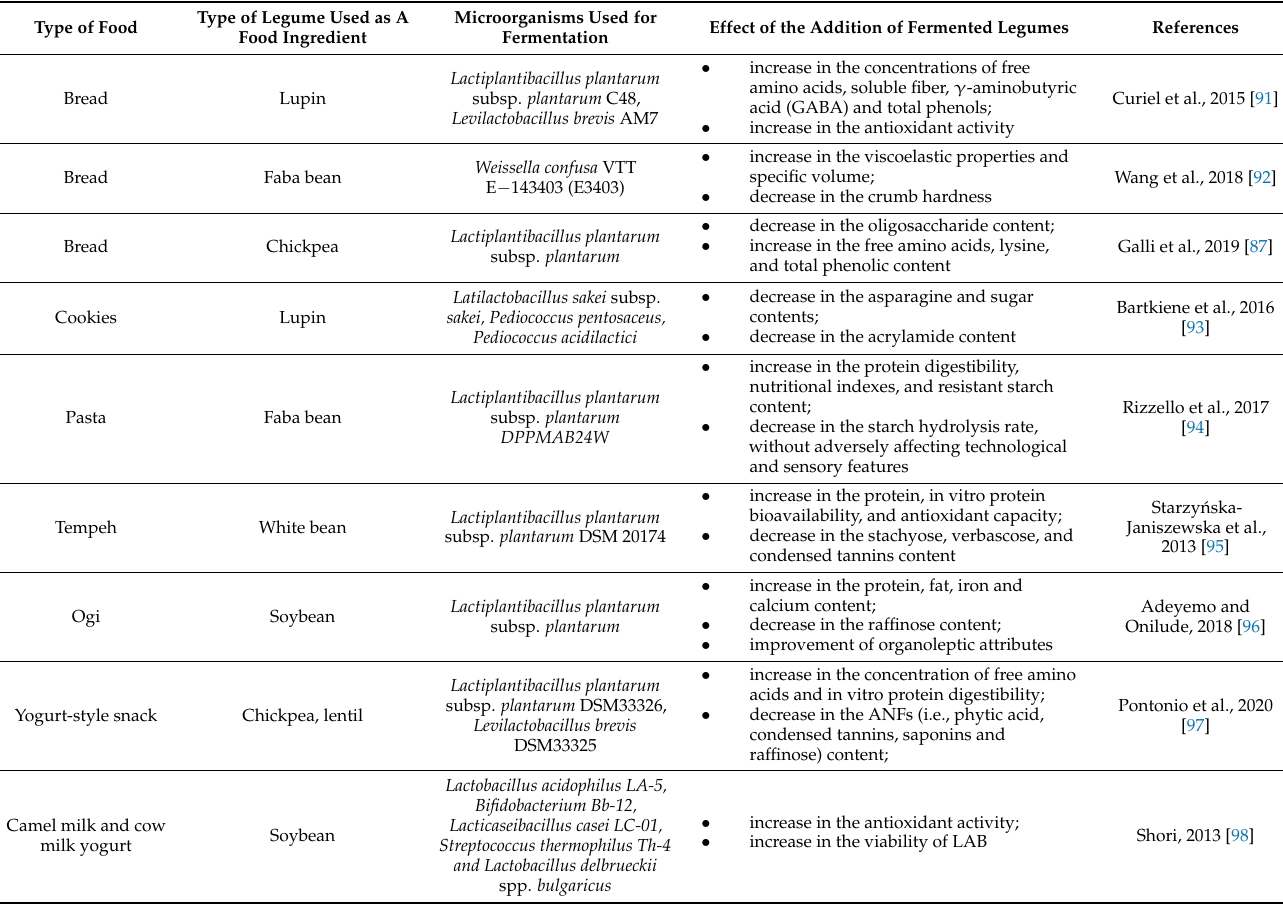
Table 3. The use of legumes fermented with LAB as ingredients of various types of